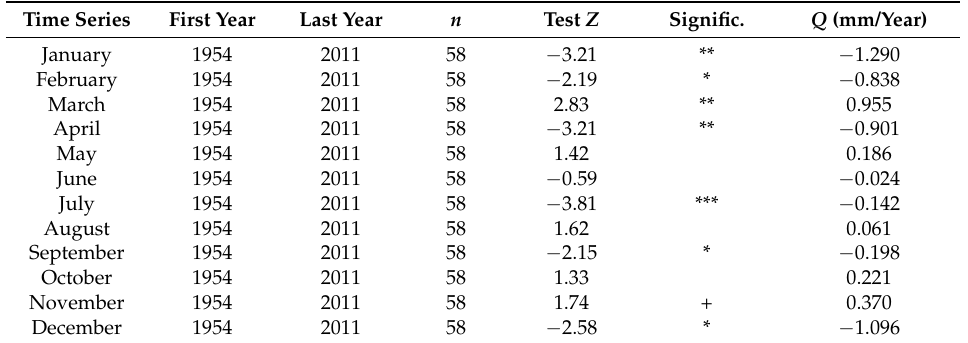
Table 1. Mann-Kendall trend and Sen’s Slope for Mtwara’s monthly moving average rainfall